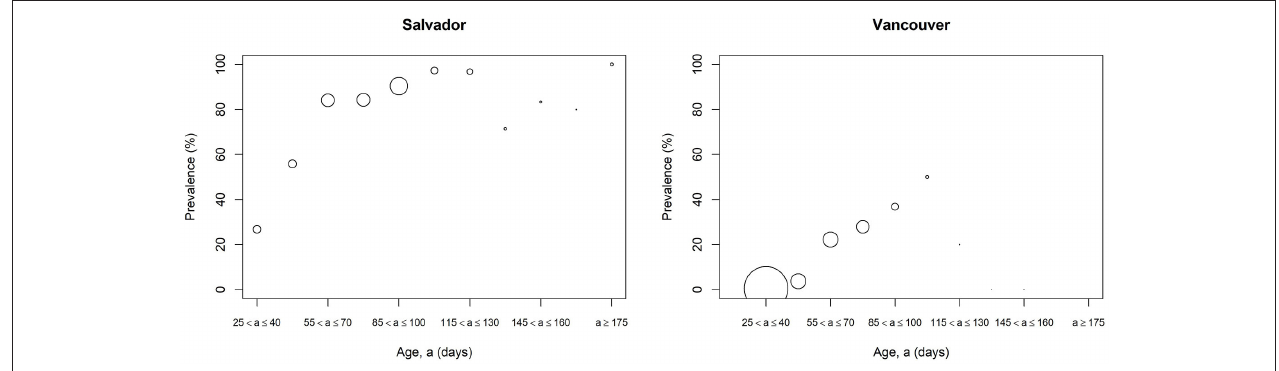
TABLE 2 | Odds ratios for being Leptospira interrogans PCR-positive among Norway rats.